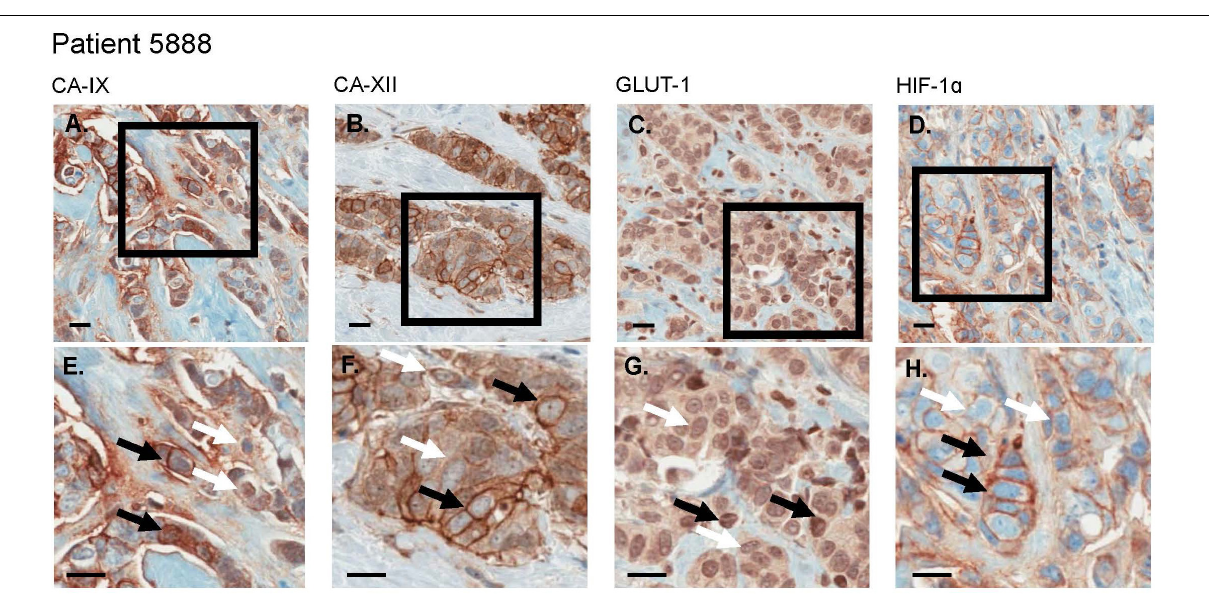
FIGURE 7 | For an invasive breast cancer patient, CA-IX, CA-XII, Glut-1, and HIF-1 α each demonstrate regions of variable biomarker expression. (A–D) display a larger number of cells wherein (E–H) are expanded views of selected regions of interest (black bounding boxes). (E–H) demonstrate both high (black arrows) and low (white arrows) expression levels (brown stain) in co-mingled populations of cancer cells. All scale bars = 20 µ